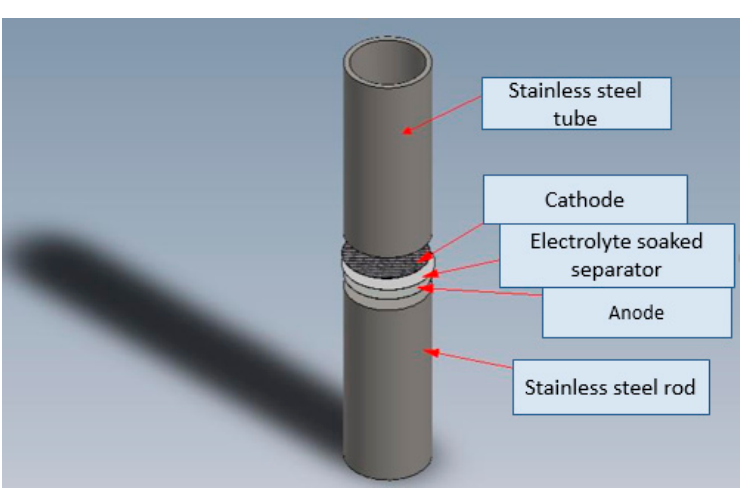
Scheme 1. Schematic depiction of the assembled Li-O 2 batteries.